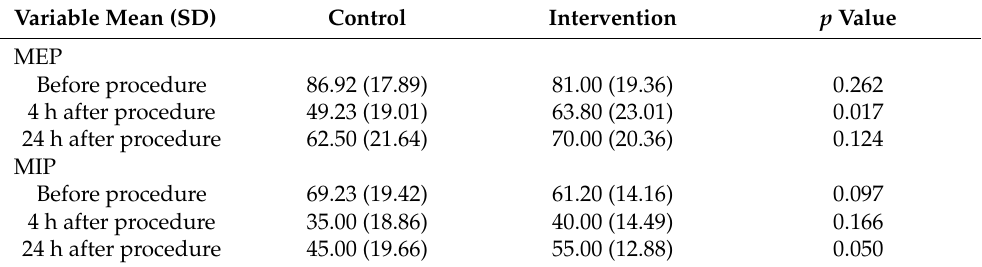
Table 6. MEP and MIP t test results. SD = standard